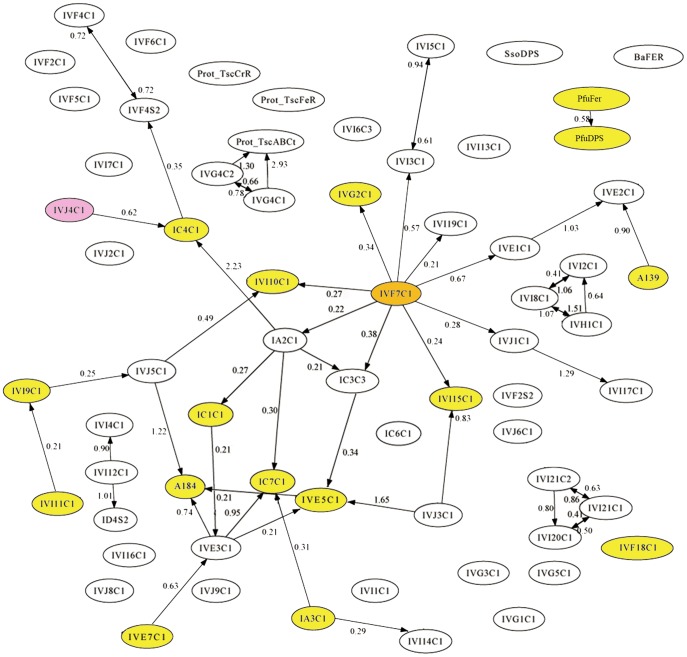
Mapping the positive immunodetections on the antibody graph G with 66 nodes and 125 links associated to our EMChip66 antibody microarray.Each node represents one antibody, and the links (arrows) represent cross-reactivity of weight Gij
[21]. Up to 18 colored nodes represent those antibody spots that rendered positive fluorescence in at least one biofilm extract. Self-loops are not shown for clarity. Prot_PfuFer and Prot_PfuDPS =  PfuFer and PfuDPS antibodies respectively.